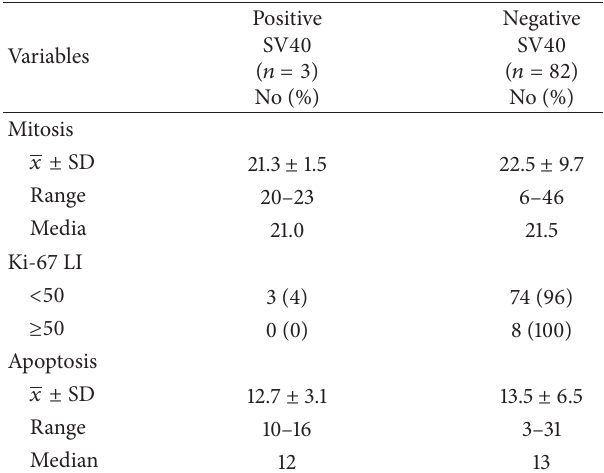
Table 2: Descriptive data for SV40 expression in